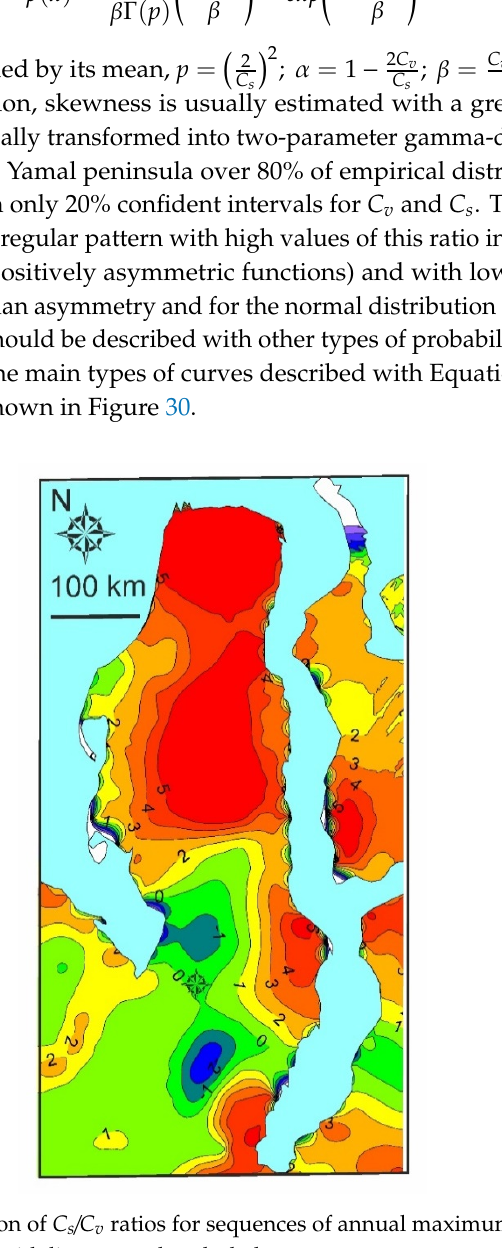
Figure 29. Spatial distribution of C s / C v ratios for sequences of annual maximum snow pack depth H s during the years 1985–2013 with linear trend excluded.